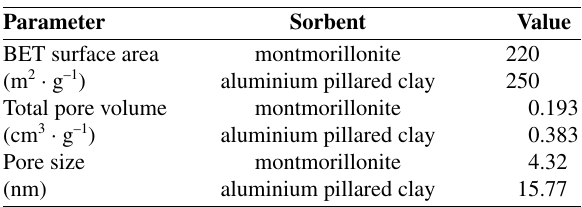
Table 1. Characteristics of the adsorbent. Parameter